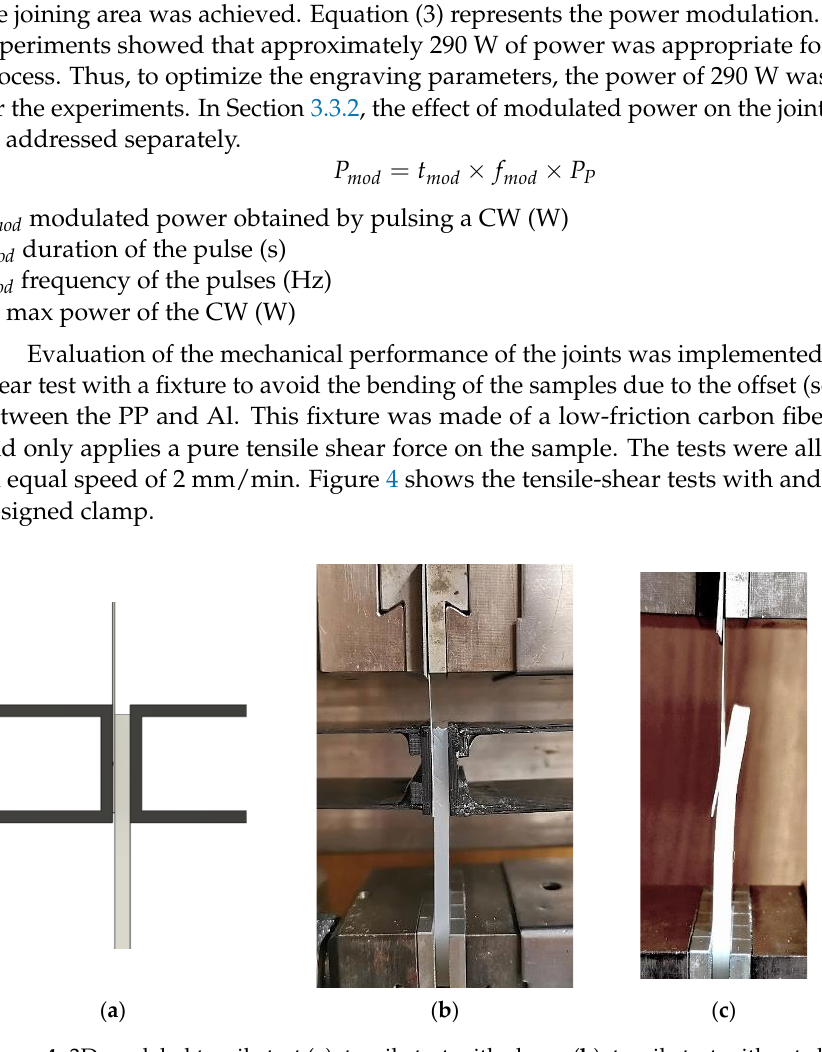
Table 2. Input Parameters of the DoE.